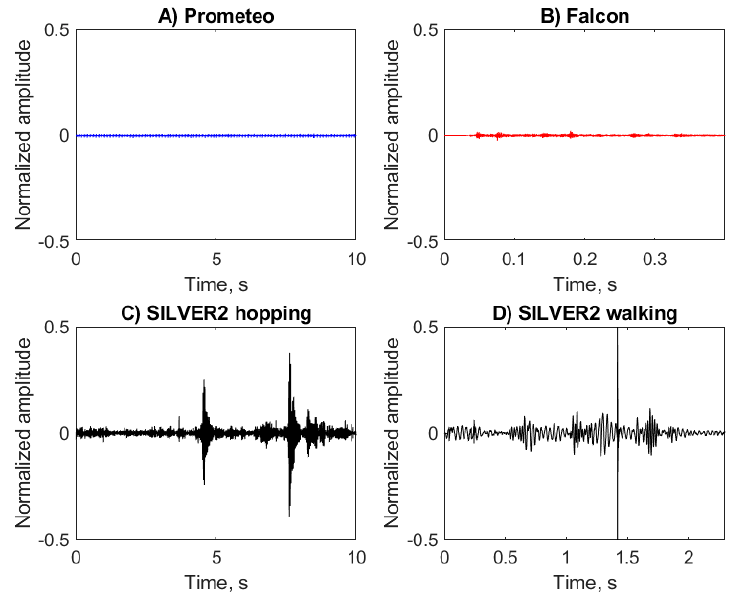
Figure 3. Raw mp3 signals of ambient noise for the four recording sessions considered.